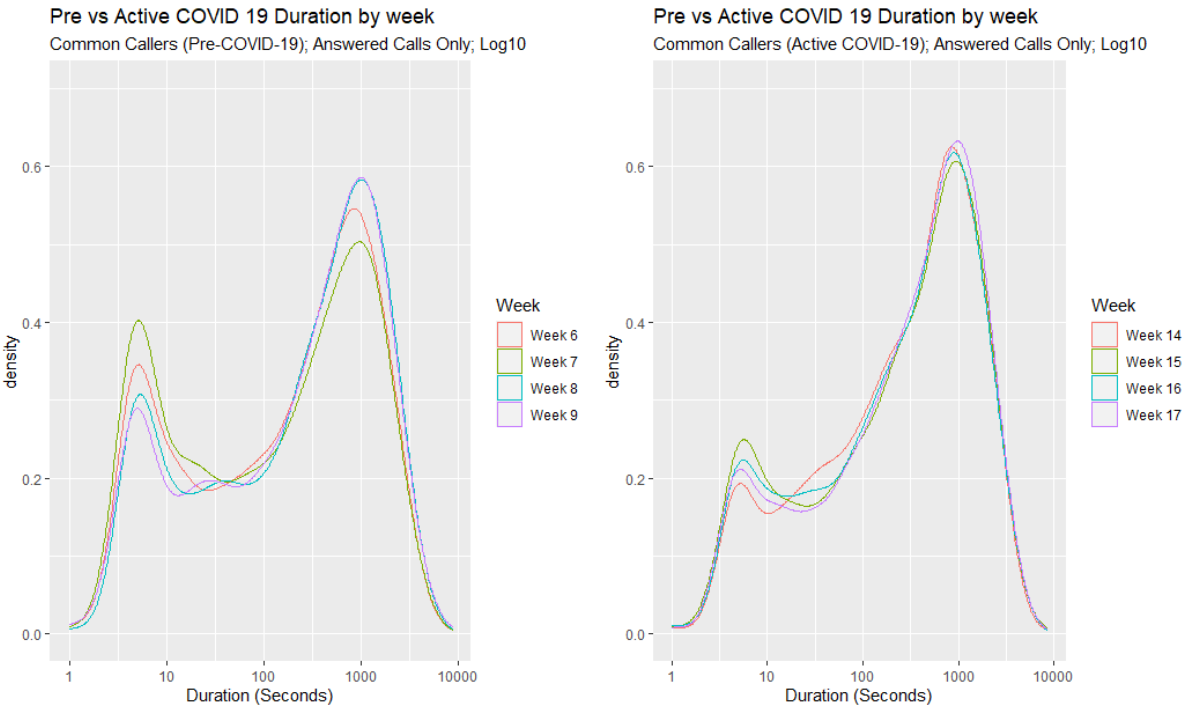
Figure 7. Density of call durations for answered calls by each week by common callers in the Pre–COVID-19 period (left) and Active COVID-19 period